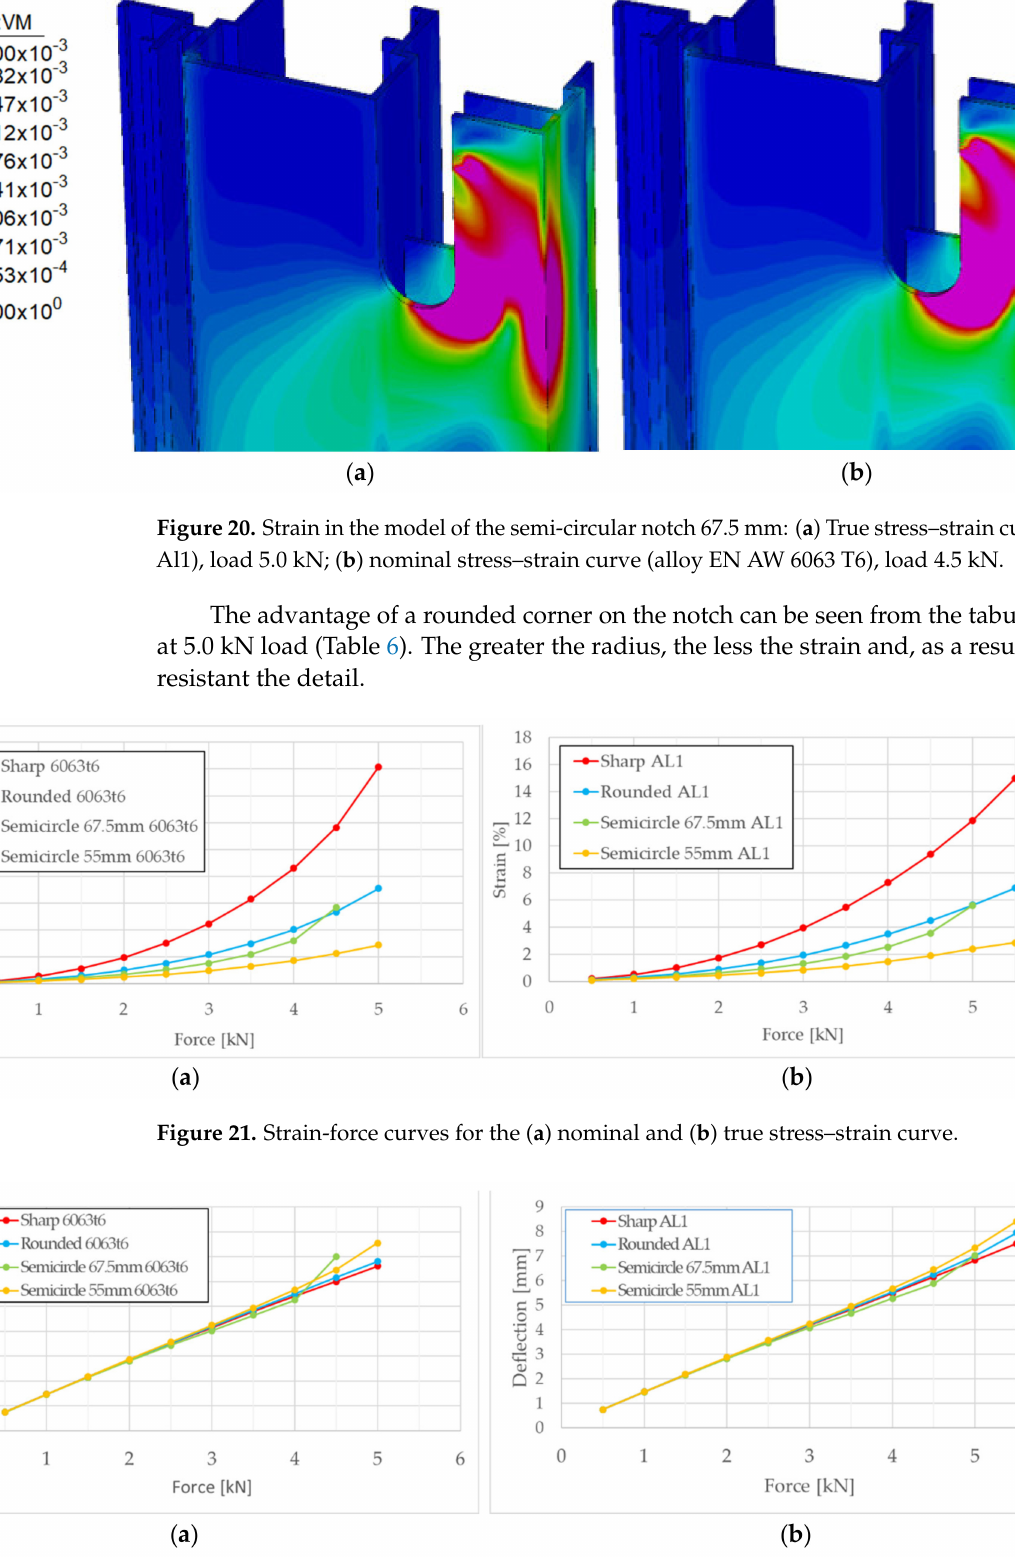
Figure 22. Deflection-force curves for the ( a ) nominal and ( b ) true stress–strain